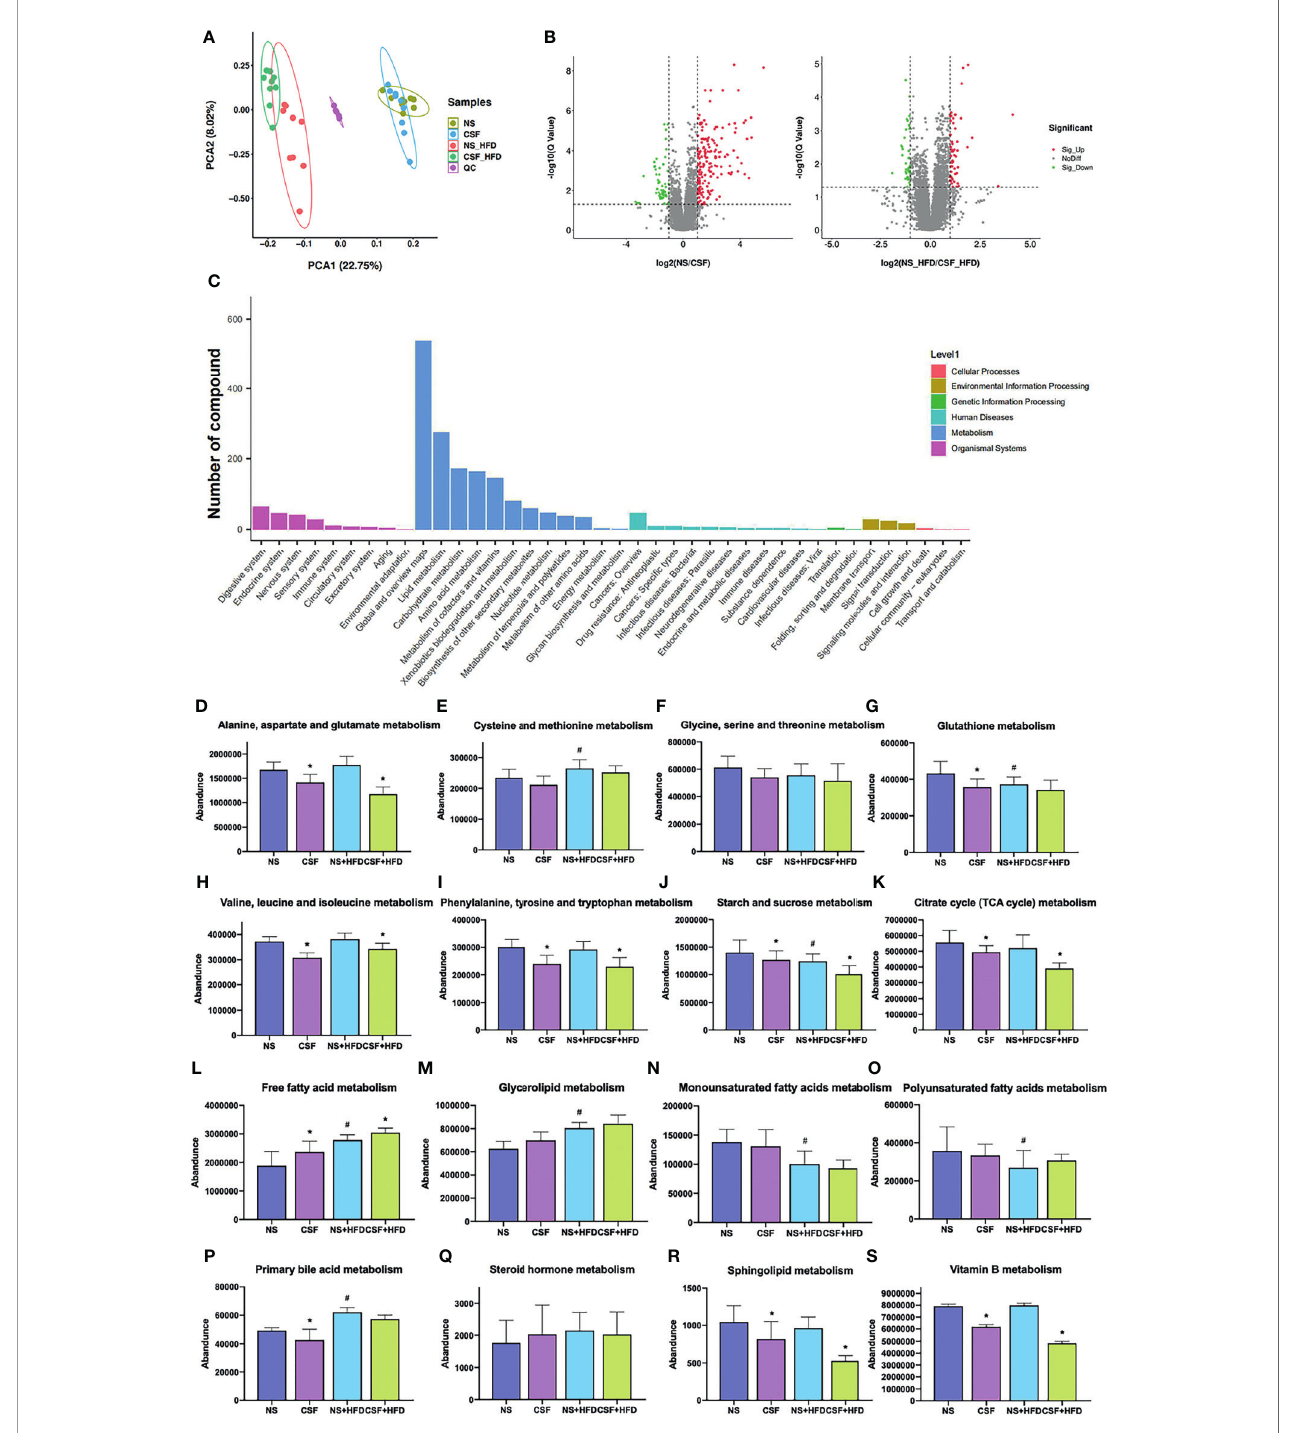
FIGURE 7 | Effects of CSF on the serum metabolome. (A) The PCA plot of metabolites generated by using the metabolite intensity from the NS (n = 9), CSF (n = 9), NS+HFD (n = 9), and CSF+HFD (n = 9) groups. (B) Volcano plots of metabolites with FDR < 0.05 and fold changes of > 4/3 or < 3/4 when comparing NS vs CSF, or comparing NS+HFD vs CSF+HFD. (C) Enrichment of activated pathways induced by alterations of metabolites in NS, CSF, NS+HFD and CSF+HFD groups. (D – S) The abundance of metabolite pathways from the NS, CSF, NS+HFD and CSF+HFD groups. Data are expressed as mean ± SEM. Group differences were assessed by using the Mann ‐ Whitney U test. *P < 0.05 when comparing NS vs CSF, or NS+HFD vs CSF+HFD, # P < 0.05 when comparing NS vs